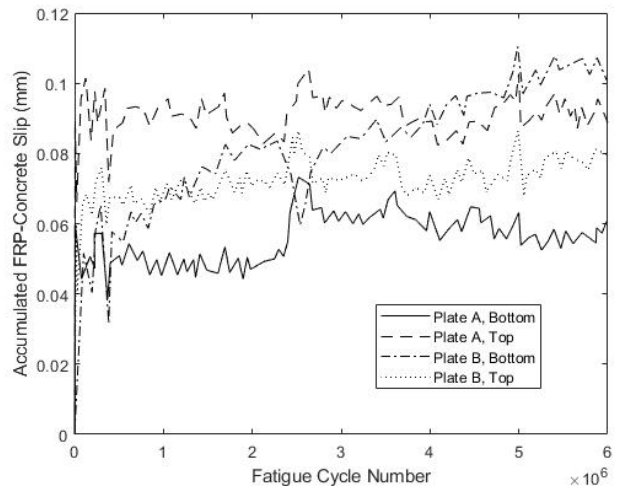
Figure 6. Fatigue-Induced Slip at FRP-Concrete Interface for S1.